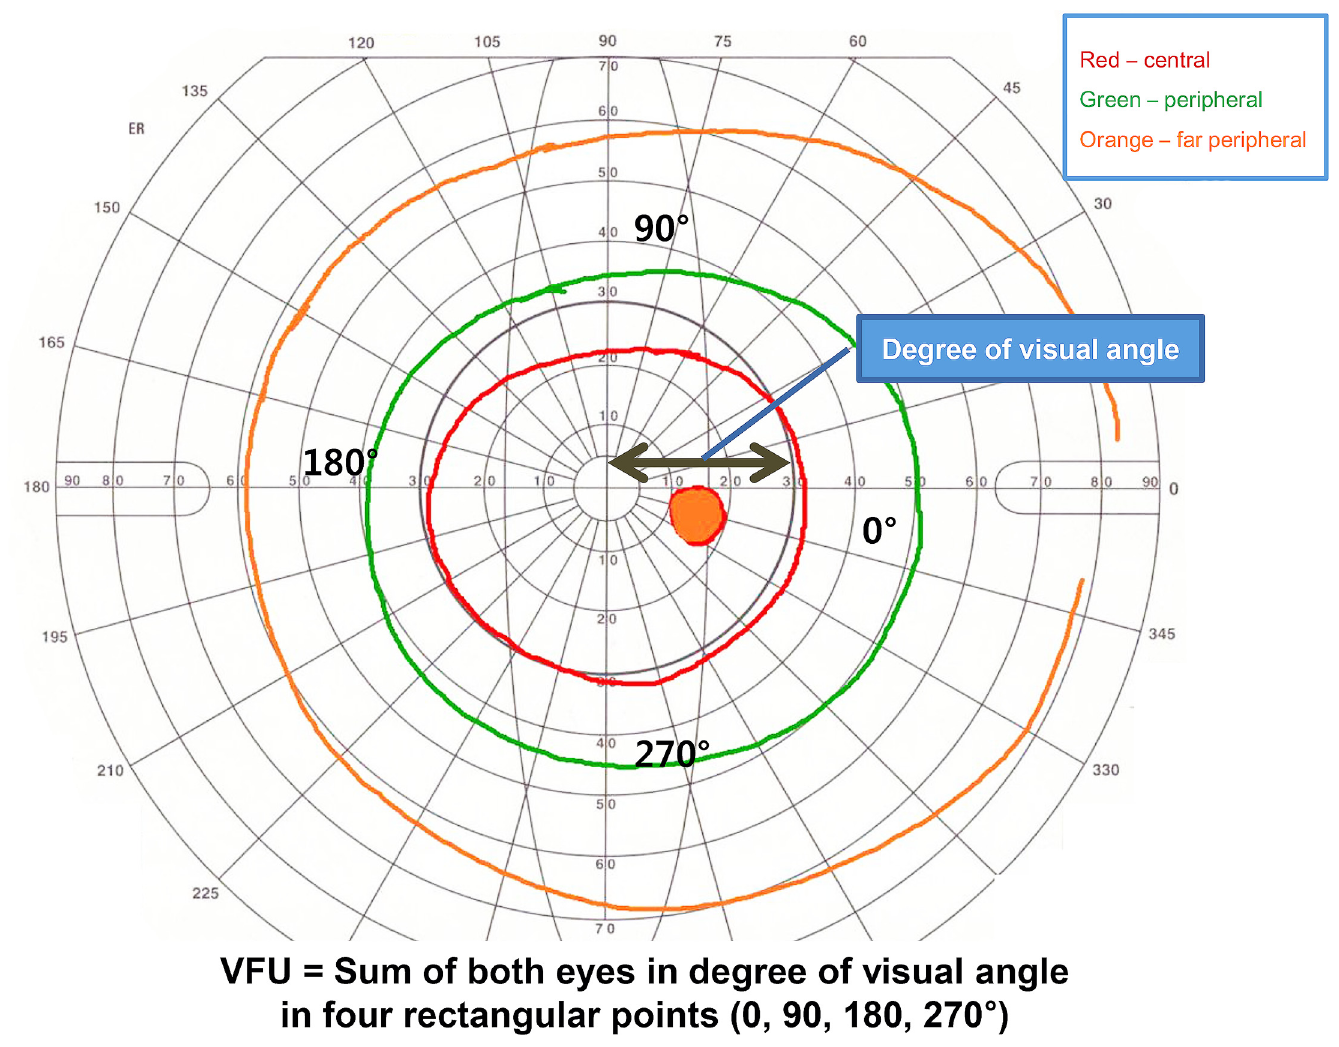
Fig 2. Example for calculating VFU in participant. Visual field unit (VFU) was determined as the sum of both eyes in the visual field degree of angle in four rectangular points (0, 90, 180, 270°) of isopters by plotting points along circles according to the stimuli. Three different colors of circle meant measured visual field of participant by Goldmann perimetry. [VFU = Sum of both eyes in degree of visual angle in four rectangular points (0,90,180,